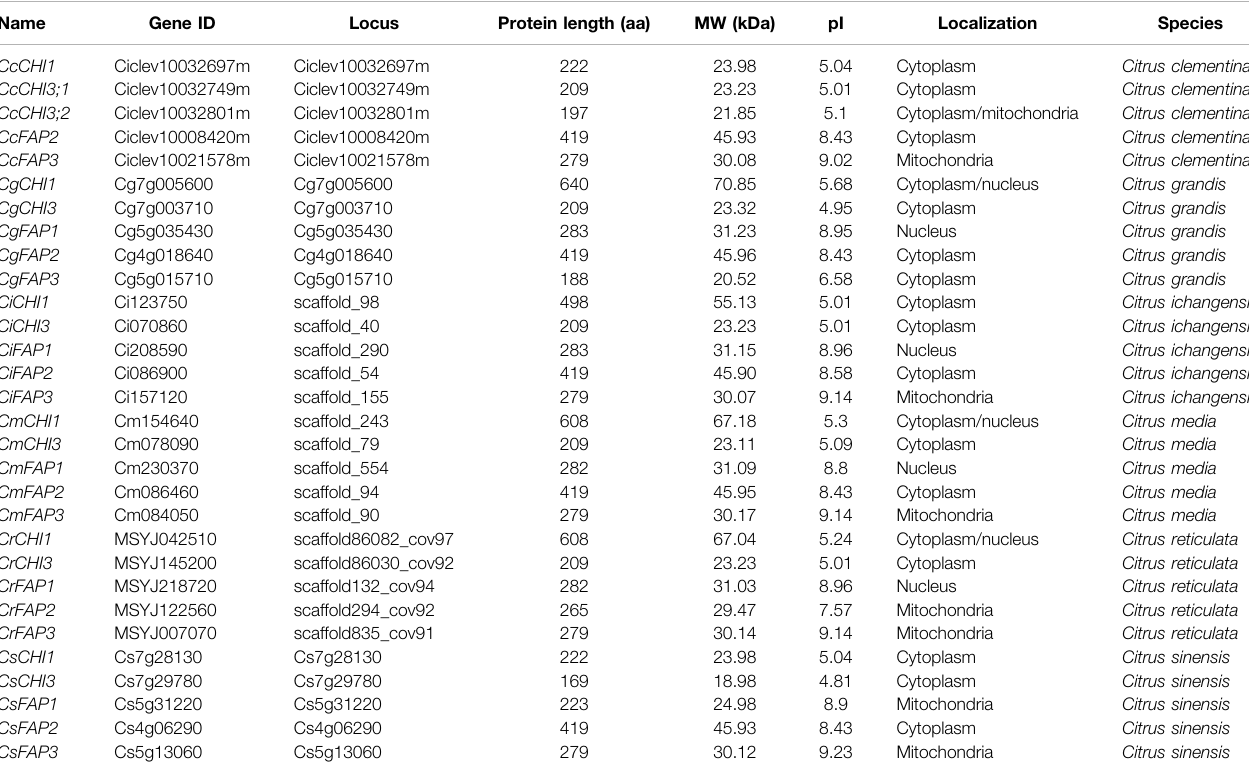
TABLE 1 | Characteristics of the CHI genes identi fi ed in Citrus